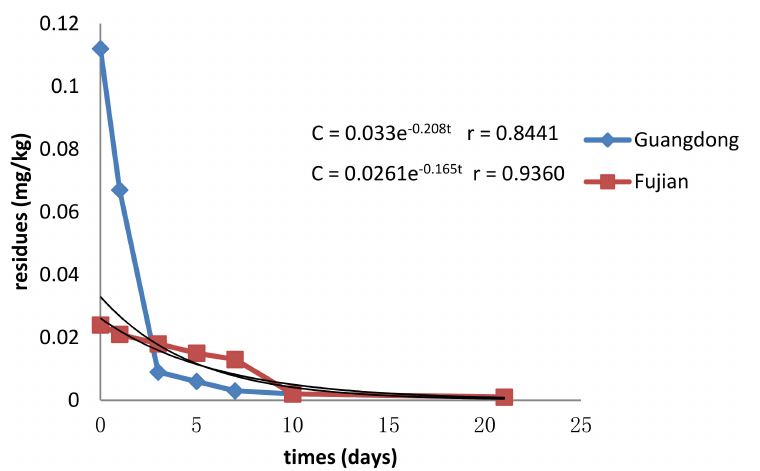
Figure 3. The dissipation pattern of emamectin benzoate in longan (lateral axis is collected sample time, and longitudinal axis is residues).